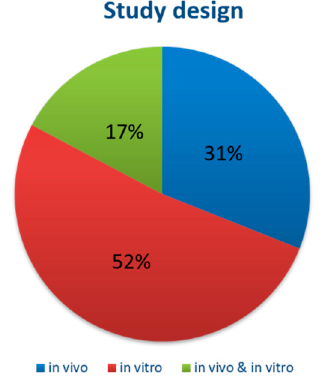
Figure 2. Synthesis of types of studies used in the review.